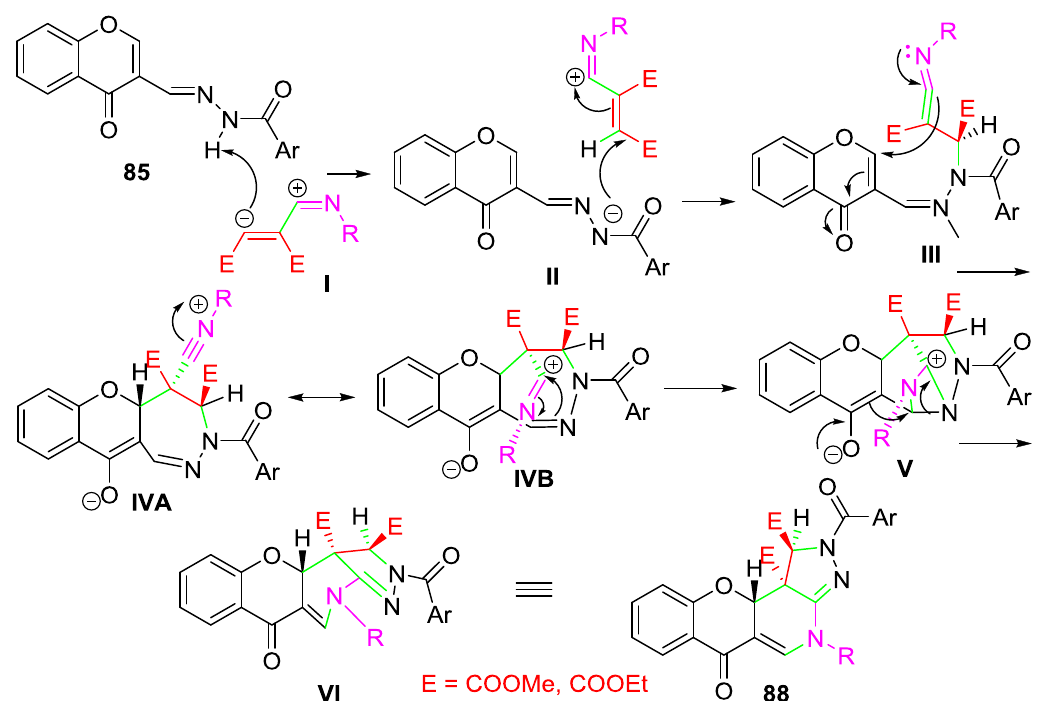
Scheme 27. Plausible reaction mechanism for the formation of chromenopyrazolopyridines 88 [56].